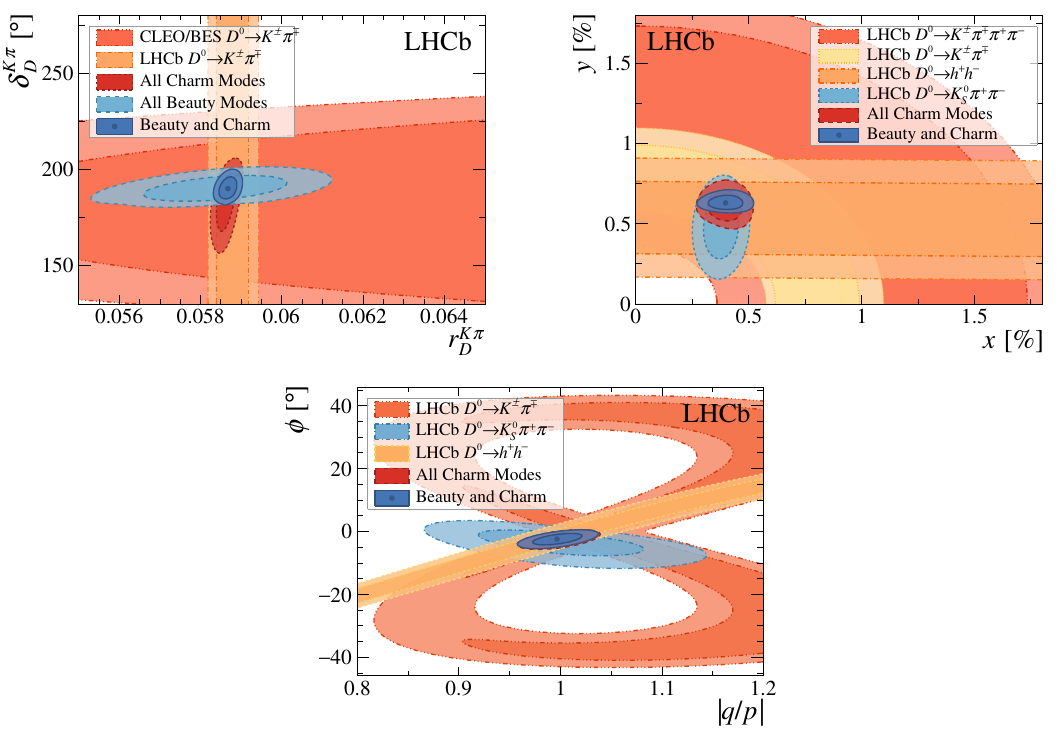
Figure 5 . Profile likelihood contours for the charm decay parameters, showing the breakdown of sensitivity amongst different sub-combinations of modes. The contours indicate the 68.3% and 95.4% confidence